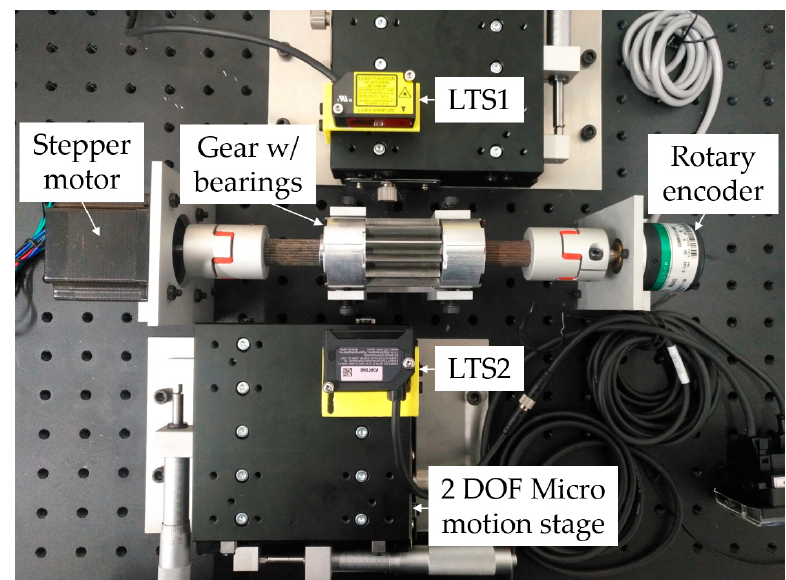
Figure 4. A photo of the experimental setup. Note the application of the twin opposing LTS’s comes from the optical requirement that the incident light beam should be near normal (±12.5°) to the target surface, otherwise the reflection light may not be strong enough to be registered by the receiver on the LTS. Thus, the LTS is placed higher than the gear axis in the z 0 direction. As a result, one half of the gear tooth incline angle satisfies the incident light beam requirement while the other does not. So, to measure the complete gear profile, two opposing LTS’s are